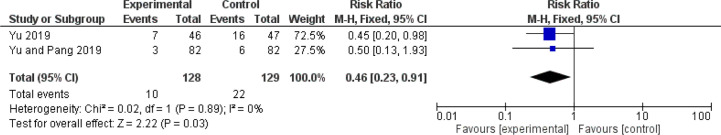
Forest plot of alopecia in patients of breast cancer (toxicity grades III–IV).